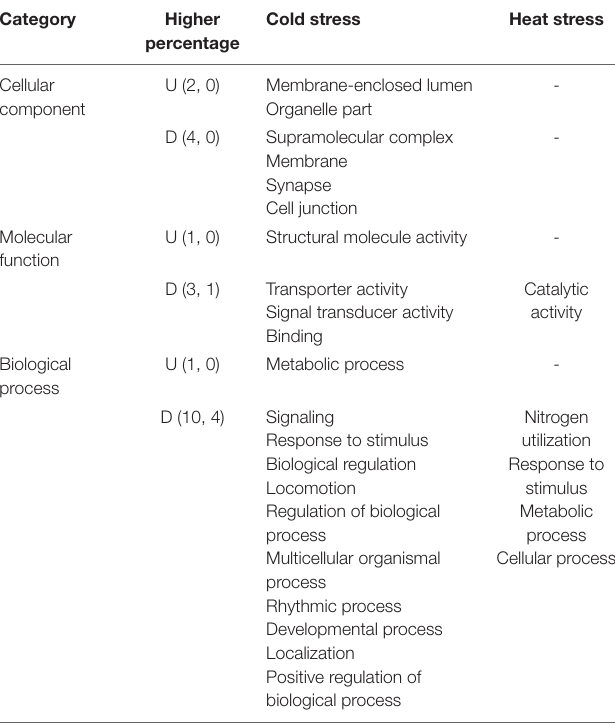
TABLE 2 | Comparison of the subcategories with significant difference between the percentages of the upregulated and downregulated genes (Pearson’s chi-squared test; p < 0.05) in Biecheleriopsis adriatica under cold and heat stress in Gene Ontology (GO) functional classification level 2.